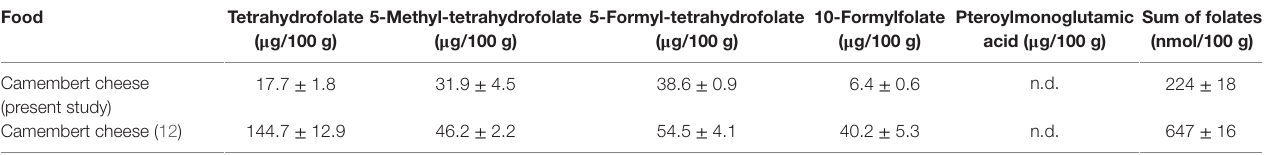
TaBle 1 | Folate distribution and sum of all folate vitamers in the test foods, mean ± sD ( n =